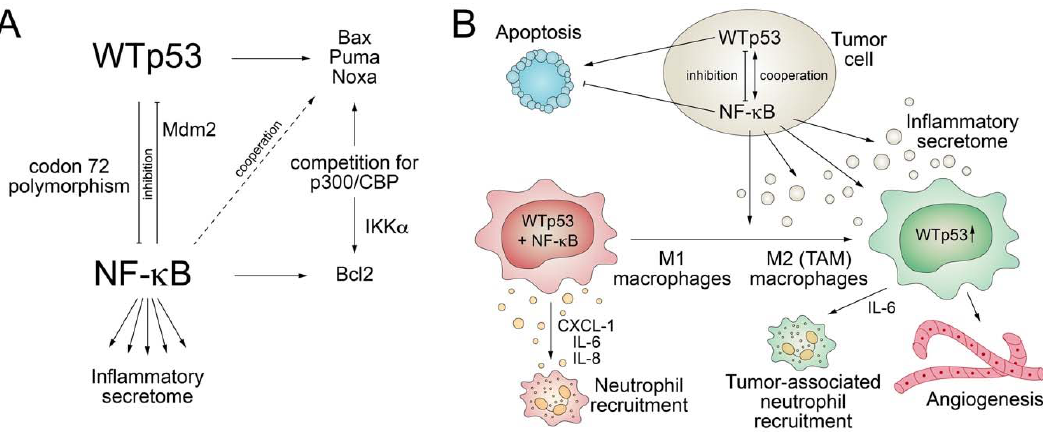
Figure 3. Abrogation of the wild ‐ type p53 secretome by TP53 mutations. ( A ) Wild ‐ type p53 crosstalks to NF ‐κ B in a mostly inhibitory, but sometimes, also cooperative manner. The outcome is context ‐ dependent manner and modulated by, for example, IKK α and the common TP53 codon 72 polymorphism. ( B ) p53 crosstalk with NF ‐κ B controls apoptosis and impacts on the inflammatory secretome, thereby regulating macrophage polarization, neutrophil recruitment, and angiogenesis. TAM, tumor ‐ associated macrophages.